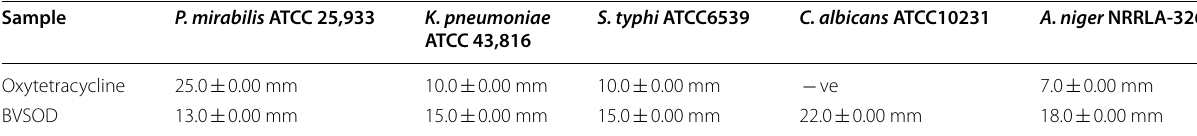
All data expressed as the mean of three reads, while no difference between reads has been observed. Oxytetracycline (OT) 30 µg was used as reference standard